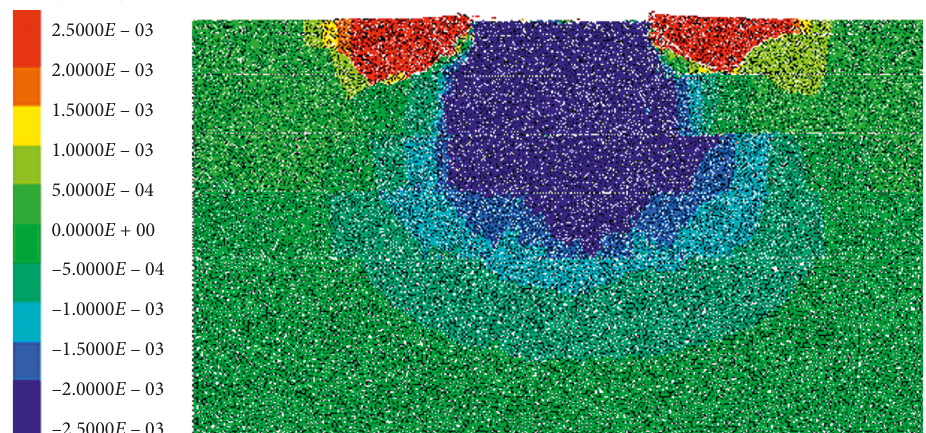
Figure 20: Vertical displacement nephogram of discrete element